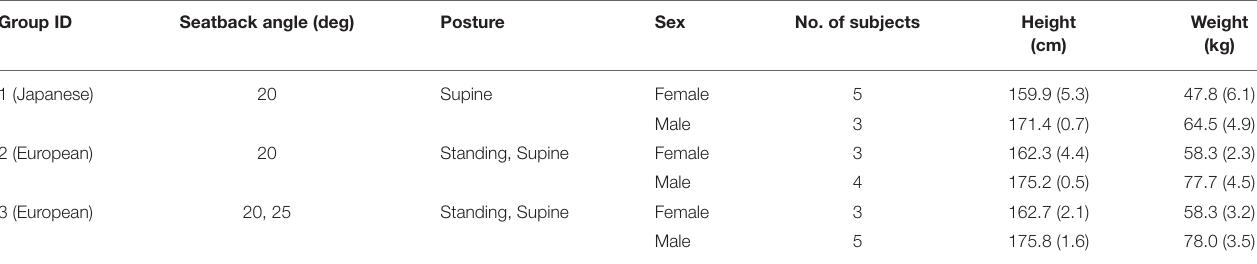
TABLE 1 | Test groups and subjects.